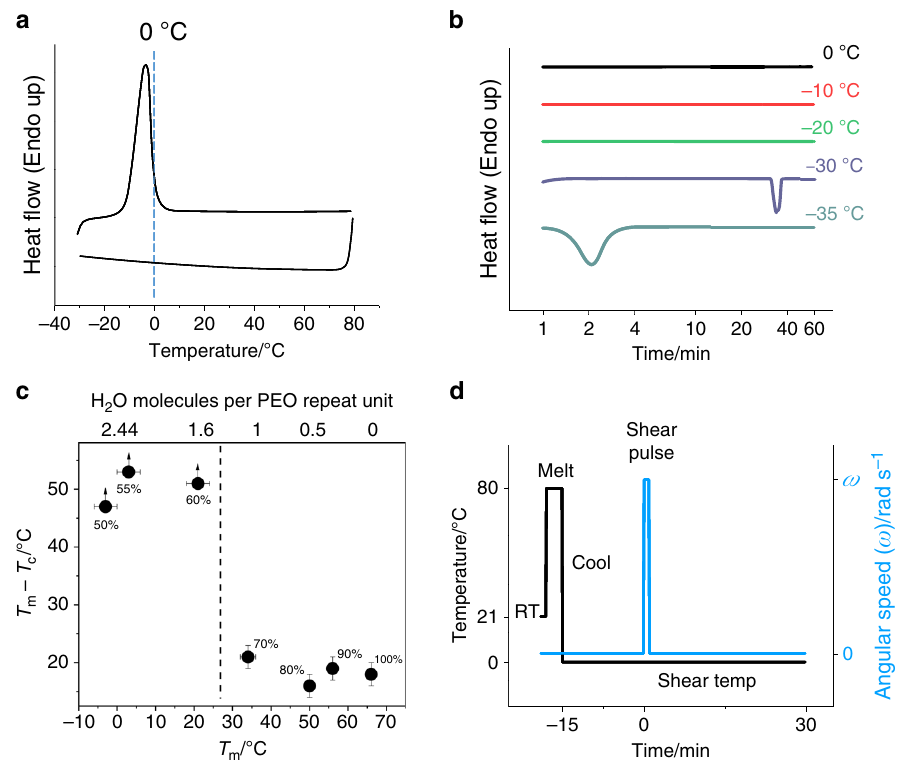
Fig. 2 DSC of PEO solutions and shear/temperature protocol used. Representative DSC results and shear/temperature protocol used for fl ow-induced nucleation of the PEO aqueous solutions. a Dynamic DSC measurements of 50% w/w PEO aqueous solution (heating/cooling rate 10 °C min − 1 ), the dashed line indicates a temperature of 0 °C which was chosen as the shear temperature. b Isothermal DSC of 50% w/w PEO aqueous solution performed at different temperatures from 0 to − 35 °C. c Measurements of the PEO hydrated shell composition (Fig. 1a); percentage values next to the plotted symbols show w/w compositions of corresponding PEO aqueous solutions; symbols with an attached arrow indicate that crystallisation was not observed as the sample was cooled after melting, and as such these data points are an estimate of the minimum amount of hysteresis present, the horizontal error bar for each point refers to the largest error of either lower ( T m ) or upper (H 2 O molecules per PEO repeat unit) axis; dotted line represents the approximate point where the hydration shell is complete, with points to the left having more than 1.6 water molecules per PEO repeat unit, and to the right less. d Shear/ temperature protocol used in fl ow-induced nucleation of 50% w/w PEO aqueous solution. Error bars, were shown, indicate the uncertainty of the measurement. (see details in “ Methods ”